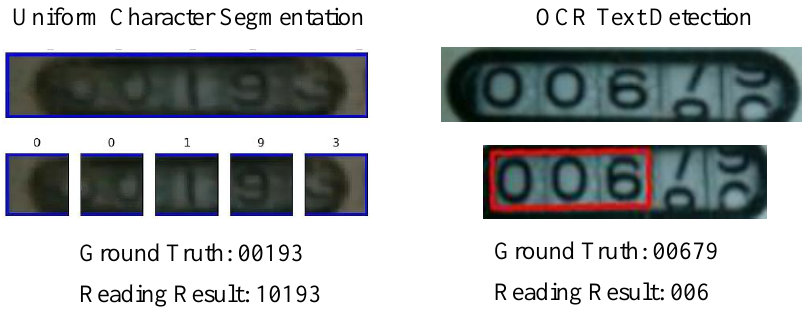
Figure 5. Uniform character segmentation and character detection. The segmentation result on the left is inaccurate, and the digits on the right are not fully detected; both lead to wrong